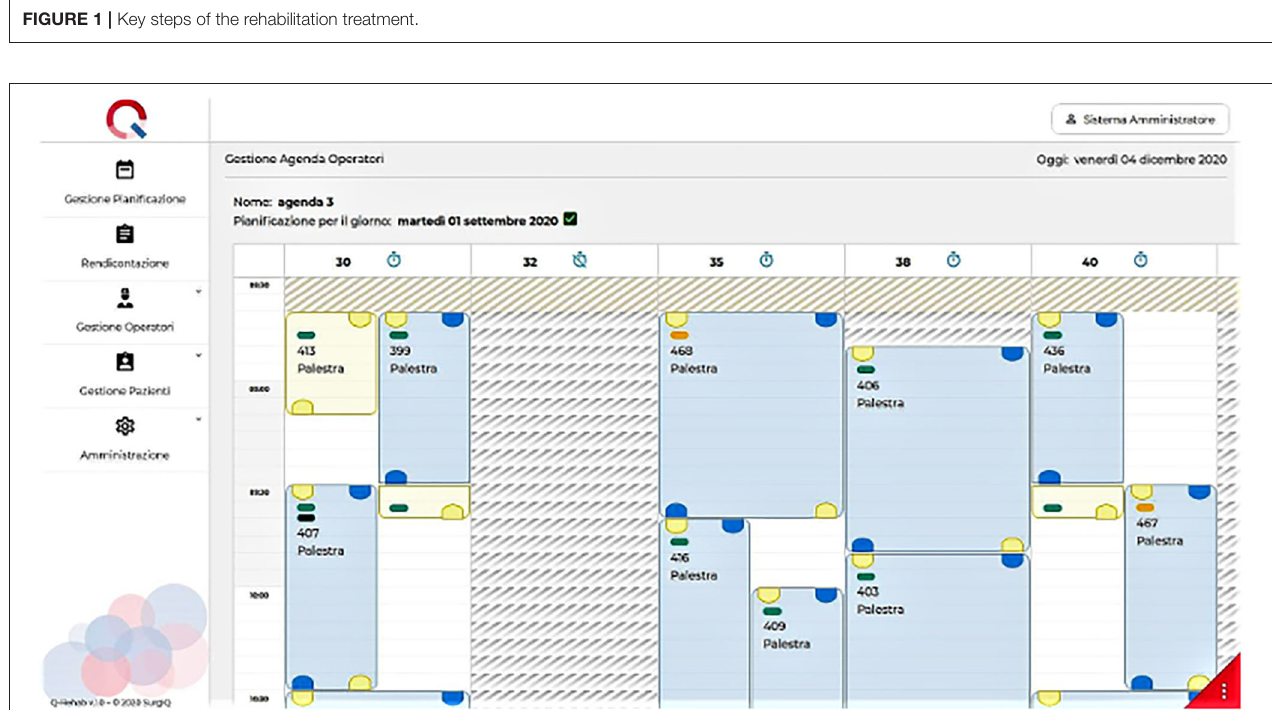
FIGURE 2 | Daily agenda as provided by Q-Rehab. Each column corresponds to a therapist’s schedule, with planned sessions represented by colored rectangles (blue for one-to-one sessions and yellow for supervised sessions).